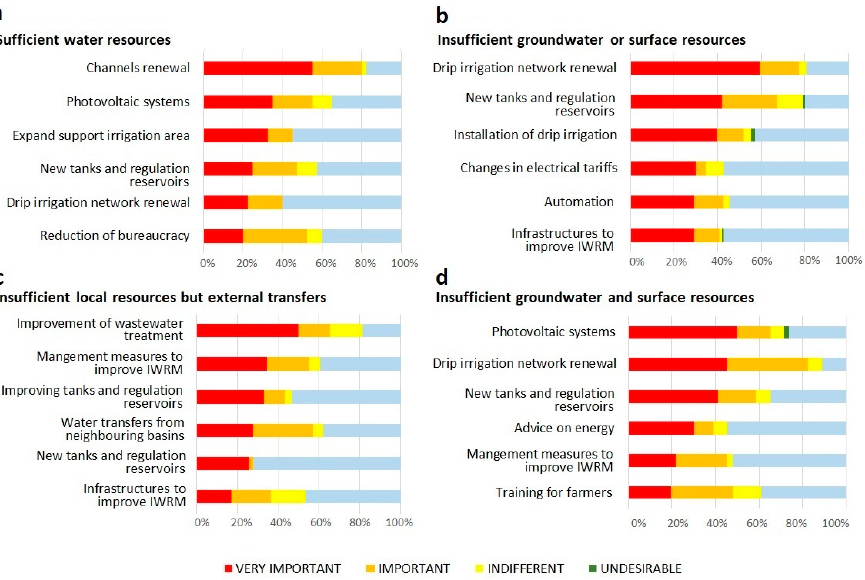
Figure 7. Measure evaluation according to water resource availability: evaluated in terms of percentage of total votes. ( a ) Sufficient water resources; ( b ) Insufficient groundwater or surface resources; ( c ) Insufficient local resources but external transfers; ( d ) Insufficient groundwater and surface resources.